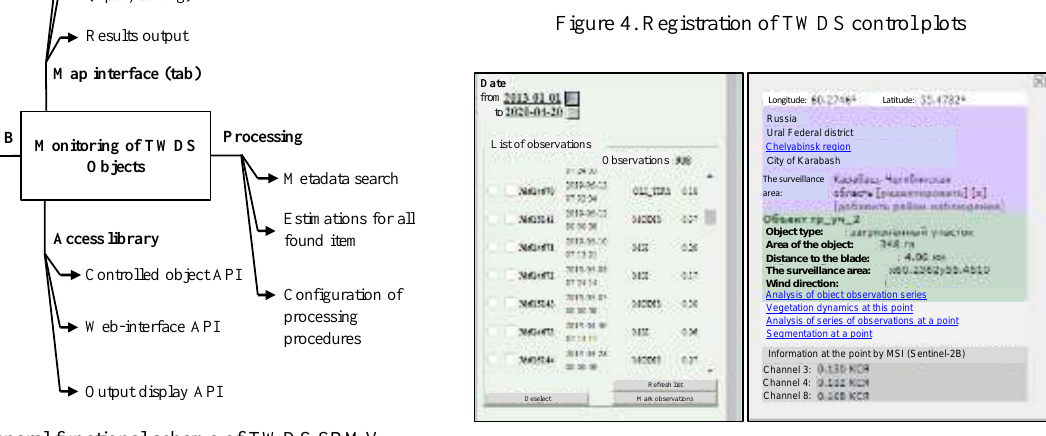
Figure 5. Output monitoring